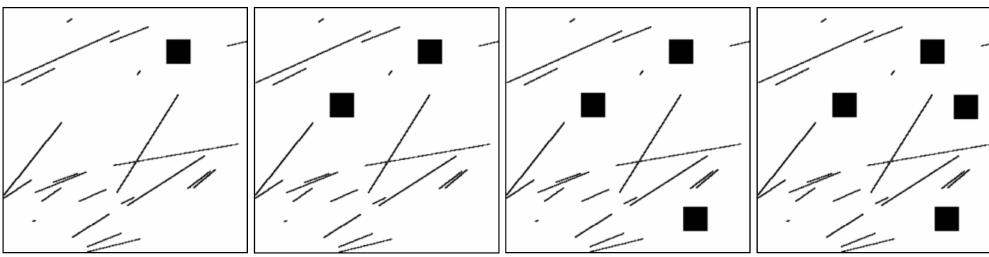
Figure 4. The fracture models with big vugs.